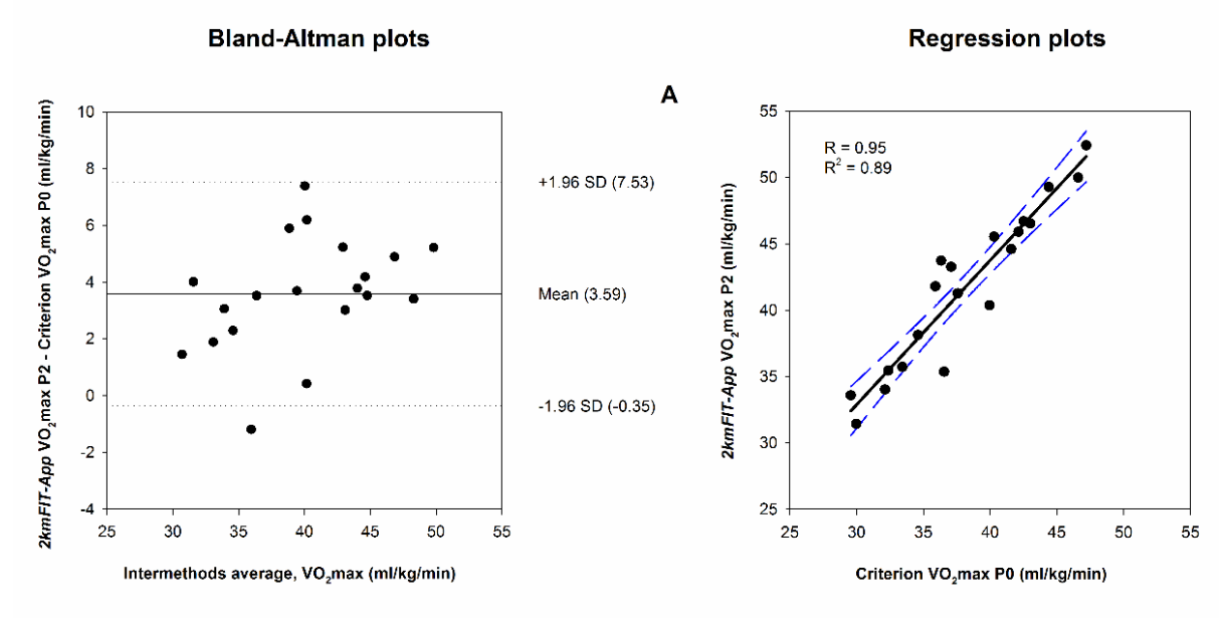
Figure 4. Agreement between the estimated app (2kmFIT-App, Android version) maximal oxygen consumption (VO2max) versus criterion VO2max. The central line represents the mean difference (systematic error) between app and criterion measures. Upper and lower dotted lines represent the 95% limits of agreement (mean difference, SD 1.96 of the differences). R: Pearson correlation coefficient; R2: determination coefficient. Agreement between app VO2max and (A) criterion VO2max P0 (VO2max estimated to the hypothetical arrival at the UKK test finish line considering walking speed and heart rate at